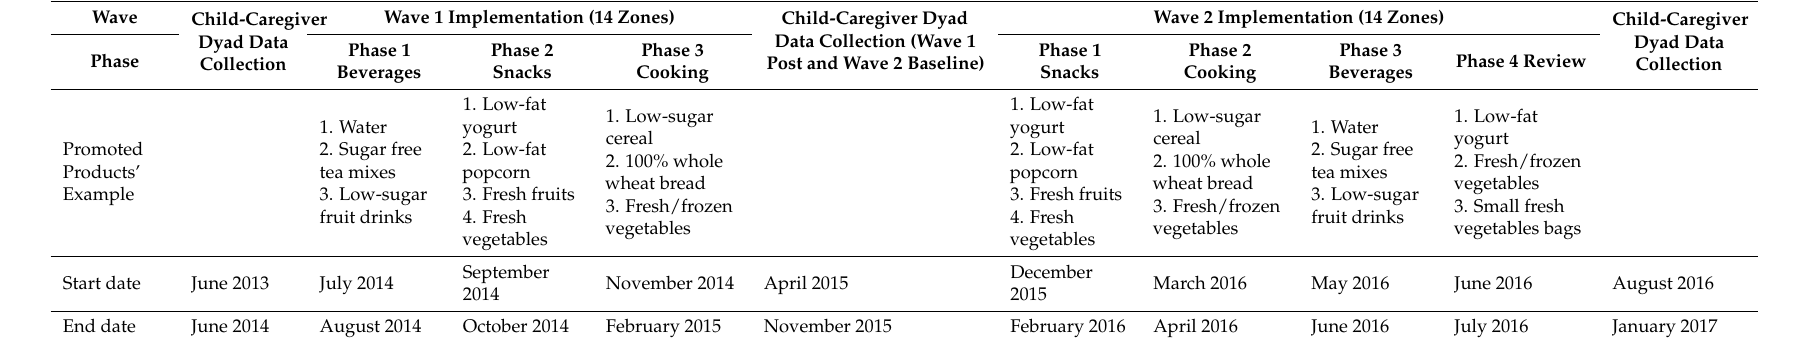
Table 1. BHCK data collection and intervention implementation